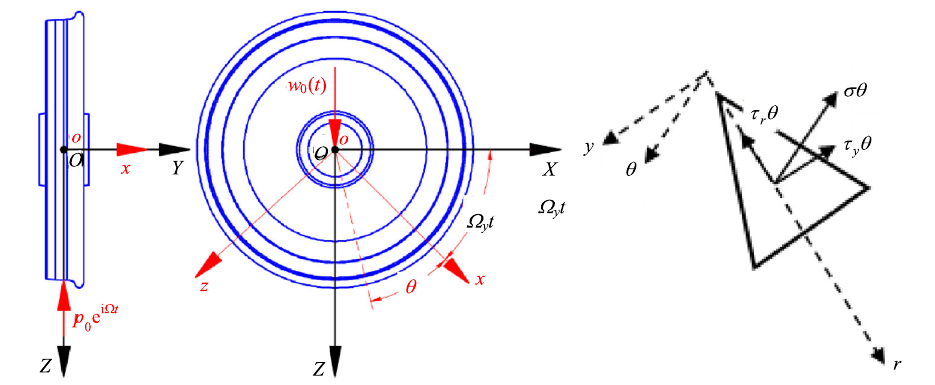
Fig. 1 Coordinate systems and an element volume